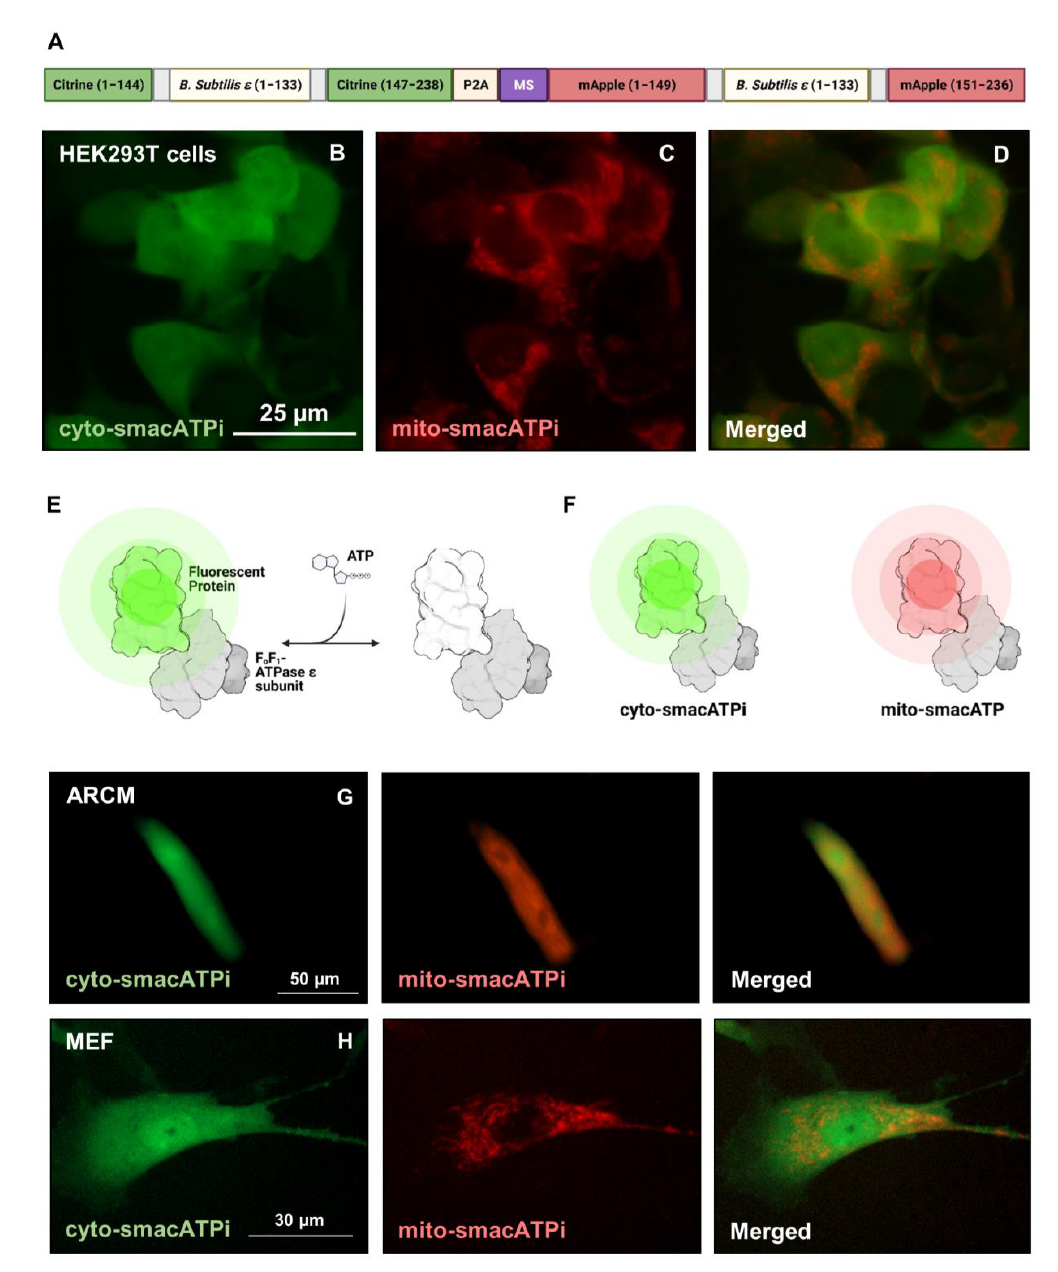
Figure 1. Dual-ATP indicator (smacATPi) design, testing, and confirmation of viability. ( A ) The simultaneous mitochondrial and cytosolic ATP indicator (smacATPi) was initially based on the previously described individual cytosolic (cyto-smacATPi) and mitochondrial (mito-smacATPi) ATP indicators, with a mitochondrial signaling sequence (MS) included for mitochondrial localization. smacATPi contains the polycistronic arrangement of sequences coding for these two MaLion fluorescent fusion proteins, along with a P2A region allowing for proper protein cleavage. ( B ) When smacATPi is expressed, the cytosolic indicator (cyto-smacATPi) indicates cytosolic ATP. ( C ) The mitochondrial indicator (mito-smacATPi) indicates mitochondrial-specific ATP. ( D ) When the indicators’ fluorescence is overlapped in living cells, ATP production and dynamic flux can be evaluated between both cellular compartments in vitro. ( E ) ATP binds to the epsilon subunit of F 1 F o -ATP synthase, triggering a conformational change in the connected protein, causing fluorescence. ( F ) The two indicators expressed from a single vector allow for the dual-compartmental visualization of ATP. ( G , H ) Representative images of ATP in adult rat cardiomyocytes (ARCM) and in mouse embryonic fibroblasts